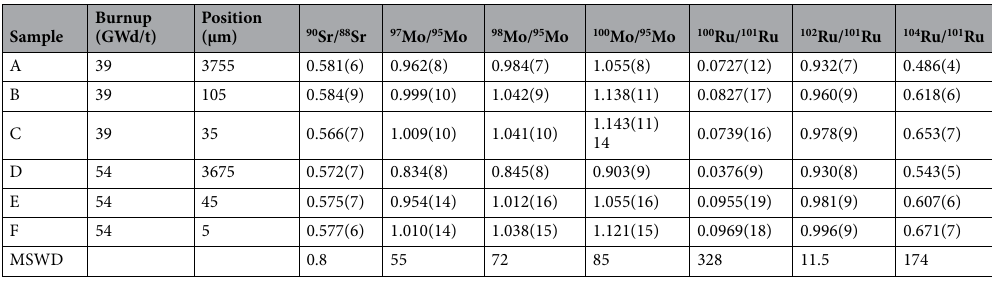
Table 3. Isotope ratios measured in spent fuel samples. Uncertainties are 1σ (see Supplemental Material for calculation of uncertainty). Sample positions are given as distance from the edge of the pellet. MSWD: mean square weighted deviation.